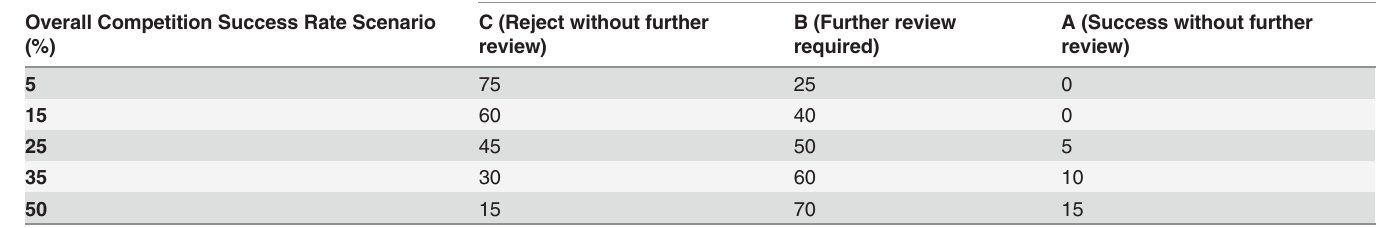
Table 1. Guidelines for